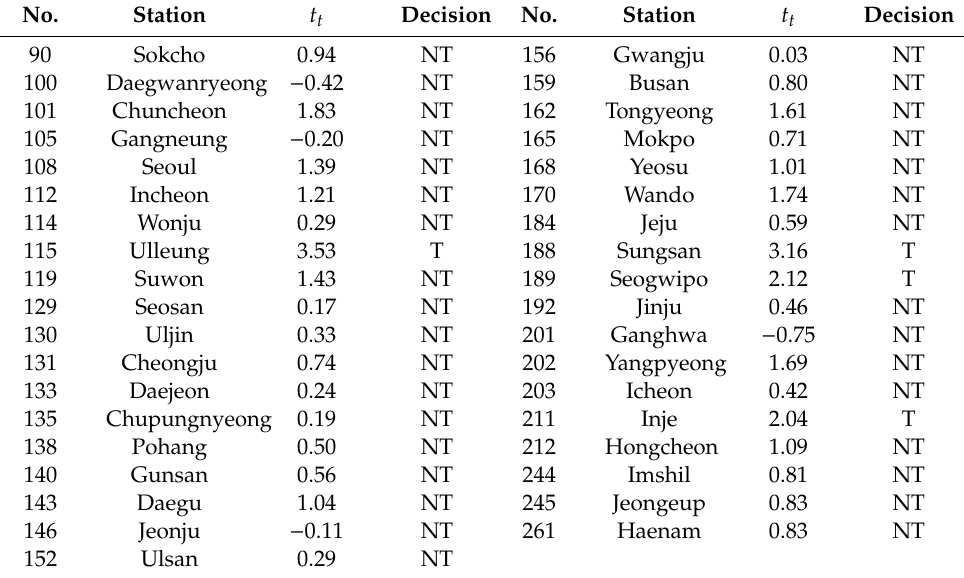
Table 3. Analysis of the Spearman rank correlation of annual precipitation data.